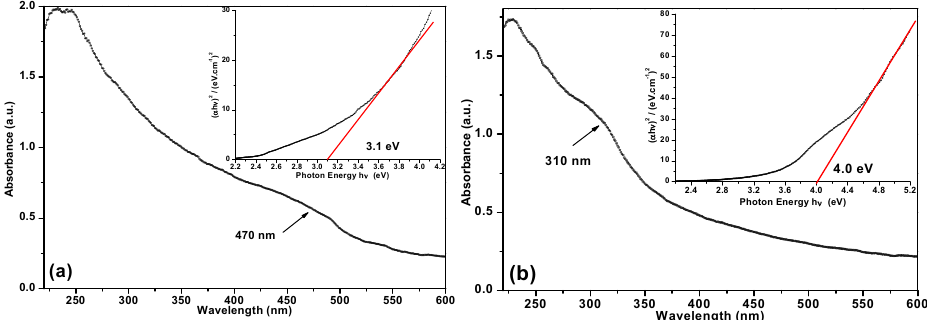
Figure 4. UV-Vis spectra and Tauc plots (as insets) of ( a ) CdS and ( b ) ZnS colloids in ethanol.